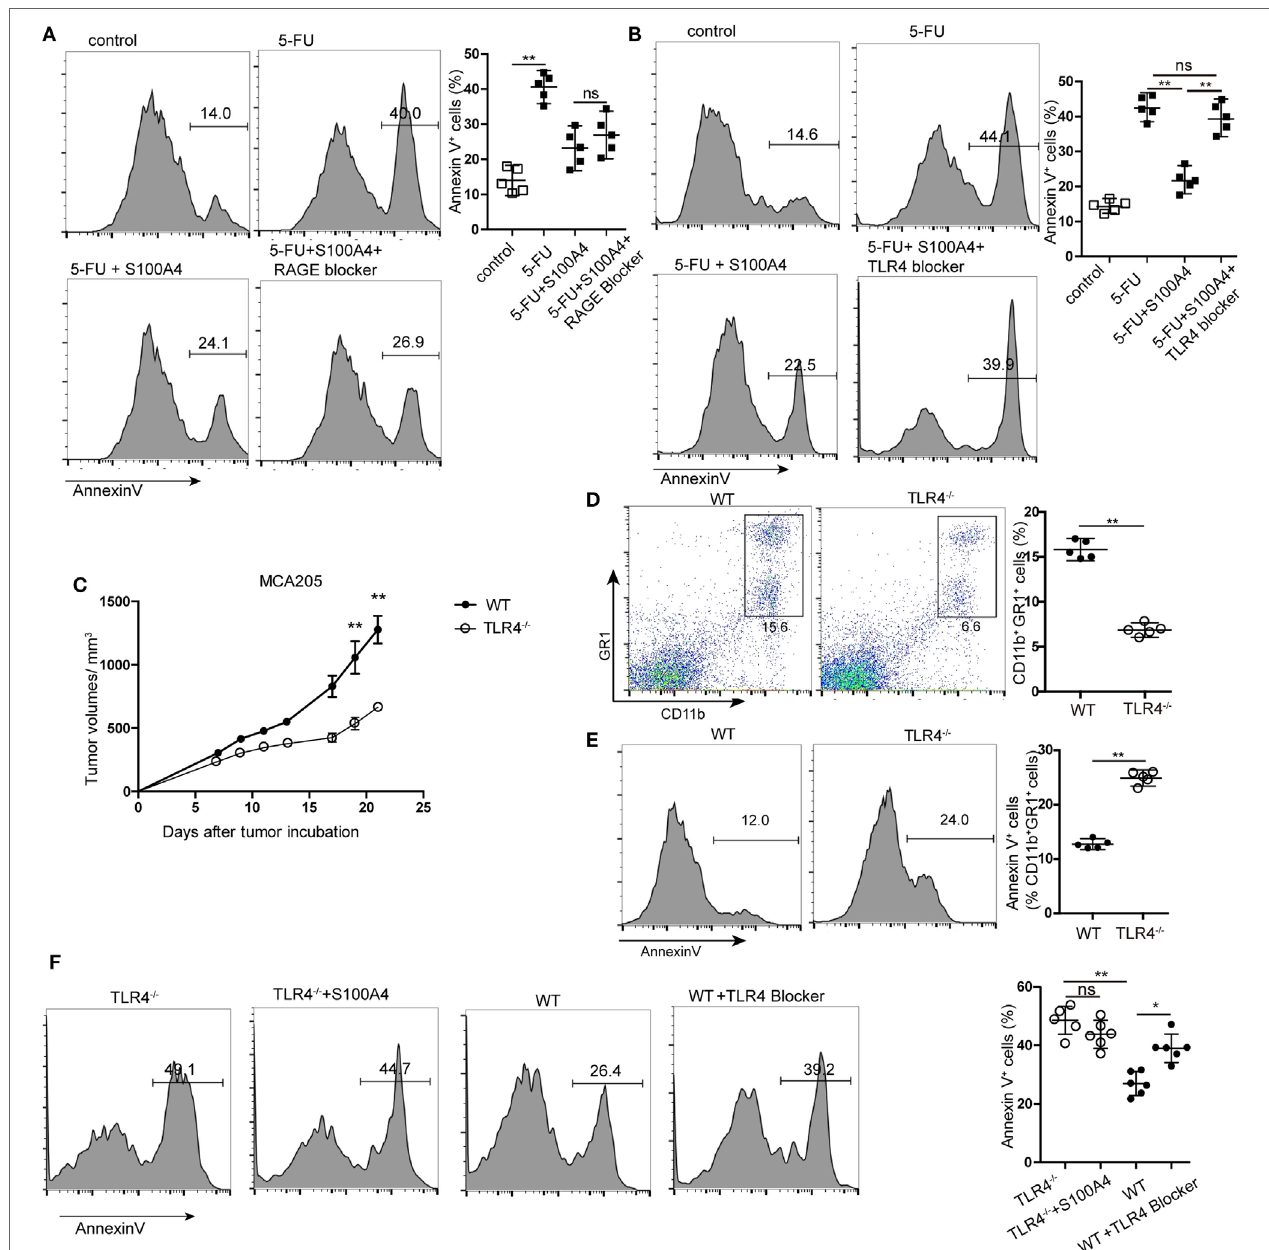
FigUre 5 | Receptor dependency of anti-apoptotic extracellular S100A4. (a,B) MSC2 cells were cultured with inhibitors of (a) receptor of advanced glycation end-products (RAGE) or (B) toll-like receptor-4 (TLR4) in the presence of 5-fluorouracil (5-FU) and S100A4, and the proportion of Annexin V + cells was determined by flow cytometry. Mean and 95% CI, n = 5 per group; ** P < 0.01, Mann–Whitney. (c) Wild type (WT) and TLR4 − / − mice were subcutaneously injected with 5 × 10 5 MCA205 cells. Tumor volumes were monitored over time after tumor-cell inoculation. Representative results of three independent experiments are shown. Mean ± SEM, n = 5 per group; ** P < 0.01, Mann–Whitney. (D,e) Spleen cells from tumor-bearing WT and TLR4 − / − mice stained for CD11b, GR1, and Annexin V were assessed by flow cytometry. Representative results of three independent experiments are shown. Mean and 95% CI, n = 5 per group; ** P < 0.01, Mann– Whitney. (F) Myeloid-derived suppressor cells (MDSCs) were isolated from tumor-bearing TLR4 − / − or WT mice and cultured in the presence of S100A4 protein (1 µg/ mL) alone or with a TLR4 inhibitor for 24 h. Cells were stained with Annexin V and assessed by flow cytometry. Combined raw data of two independent experiments are shown. Mean and 95% CI, n = 6 per group; * P < 0.05, ** P < 0.01, and